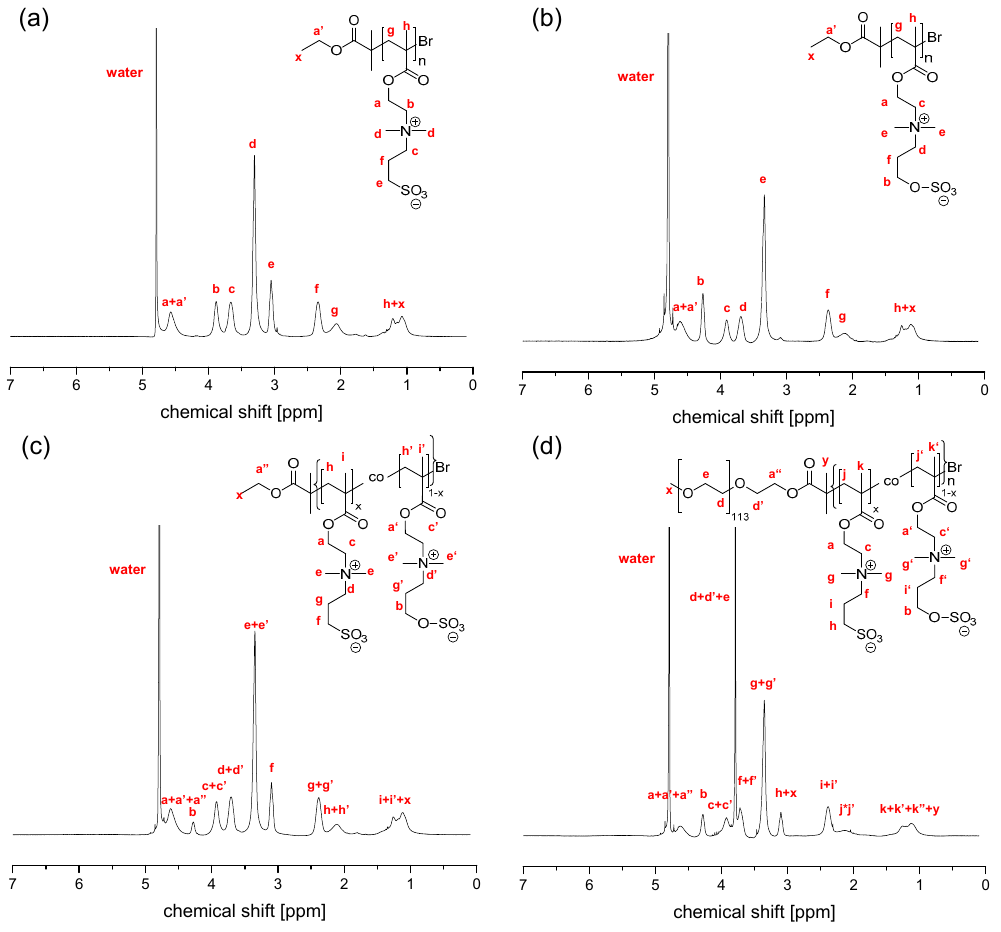
Figure 3. 1 H NMR spectra in 0.5 M aq NaCl (D 2 O) of ( a ) homopolymer PSPE-2, ( b ) homopolymer PZPE-1, ( c ) statistical copolymer P(SPE- co -ZPE)-1, and ( d ) statistical block copolymer mPEG- b -P(SPE- co -ZPE)-2.